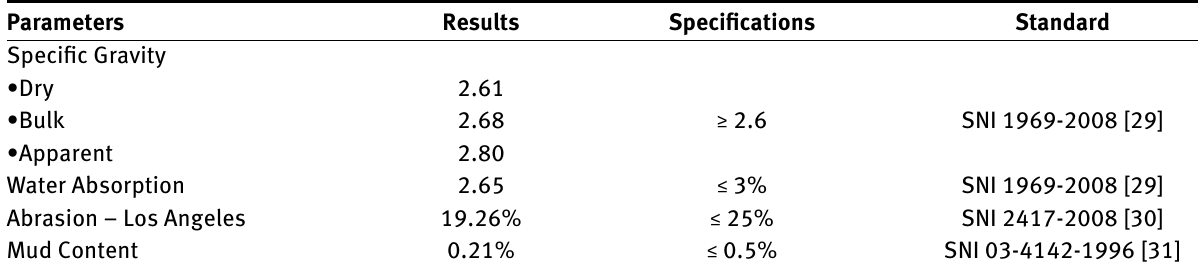
Table 1: Examination of aggregate physical and mechanical properties